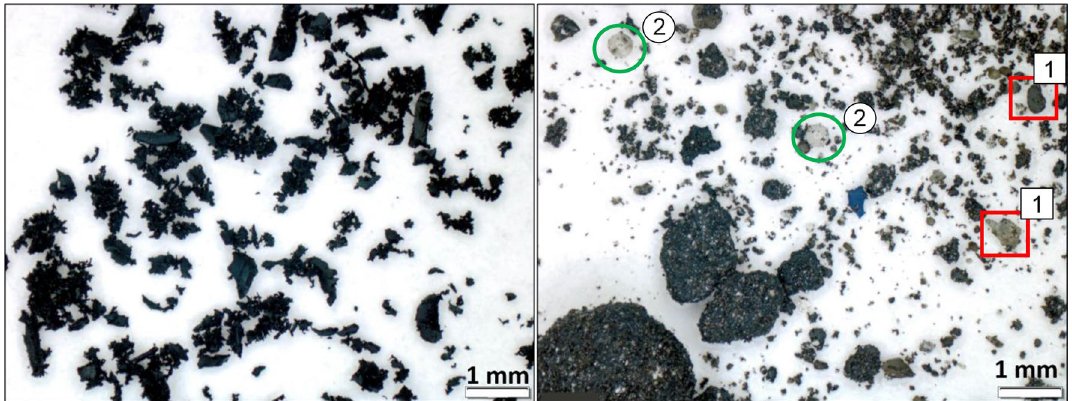
Figure 5. Microscopic image of rubber powder (left) and TWAP (right).